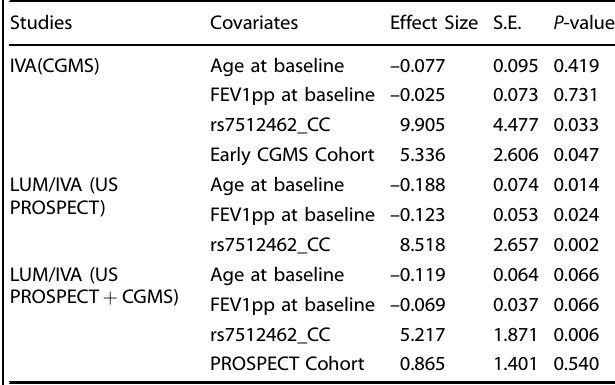
Table 3. Association of rs7512462 with CFTR modulator